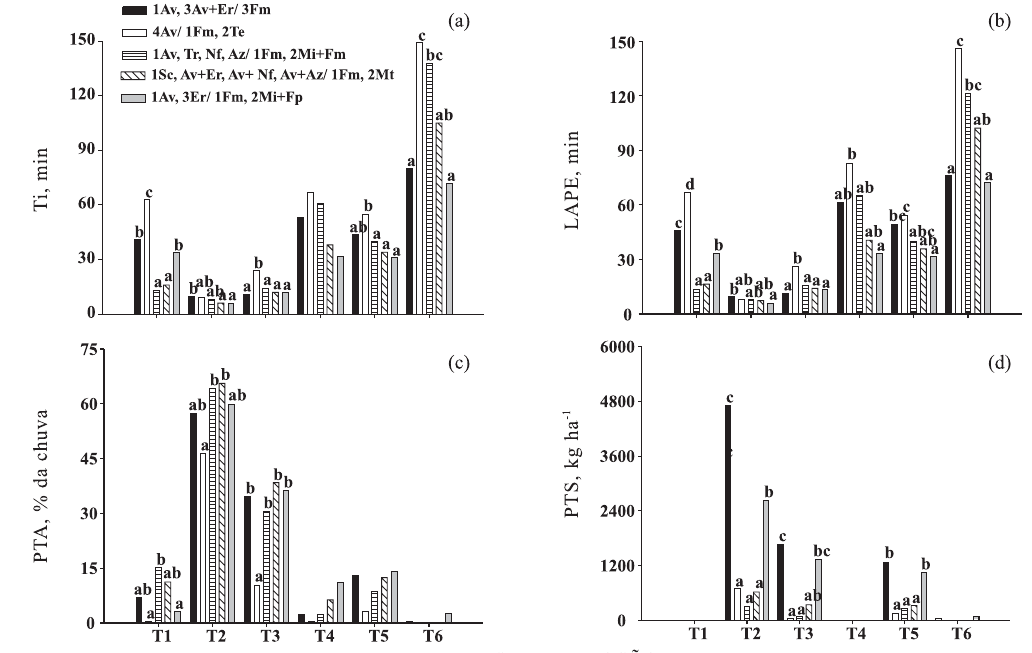
Figura 1. Tempo de início da enxurrada (Ti - a), lâmina de água retida no sistema no período pré-enxurrada (LAPE – b), perda total de água (PTA - d) e perda total de solo (PTS – d) nas sequências culturais estudadas, nos testes de erosão realizados na pesquisa (T1: solo não mobilizado, crosta normal, 100% coberto; T2: solo não mobilizado, crosta rompida, 18% coberto; T3: solo não mobilizado, crosta tênue, 18 % coberto; T4: solo recém-escarificado, 100% coberto; T5: solo previamente escarificado – em T4 – 18 % coberto, T6: solo recém-gradeado - após T5 – descoberto). Colunas sobrepostas pela mesma letra, no mesmo teste de erosão, não diferem estatisticamente entre si pelo teste de Tukey a 10 %, enquanto ausência de letra nelas representa falta de significância